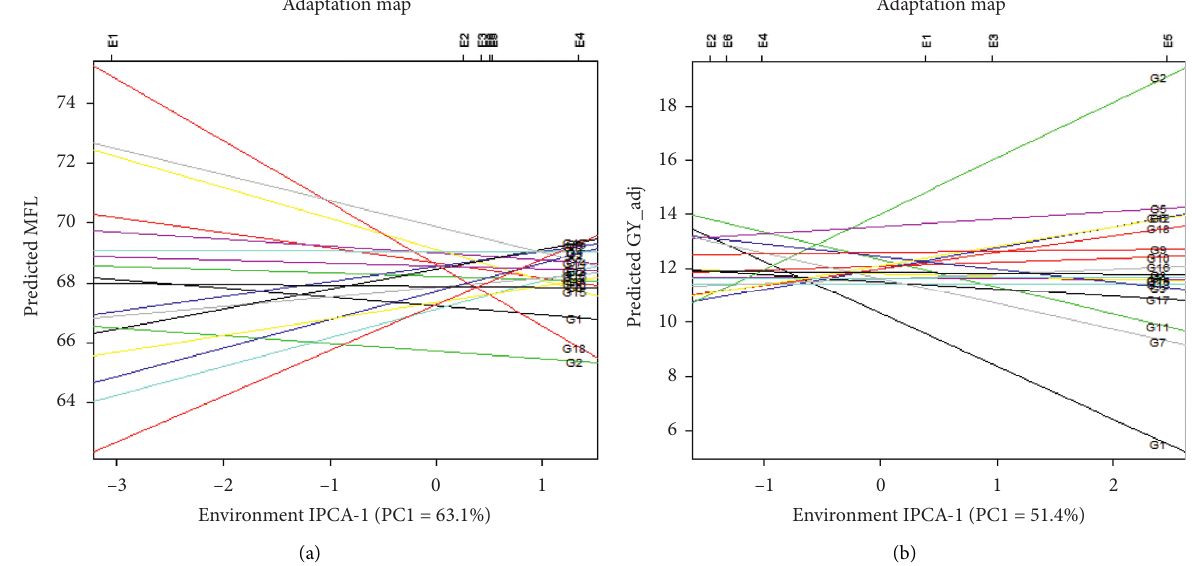
Figure 3: Adaptation map of Indonesian sweet corn for (a) male flowering (dap: days after planting) and (b) grain yield